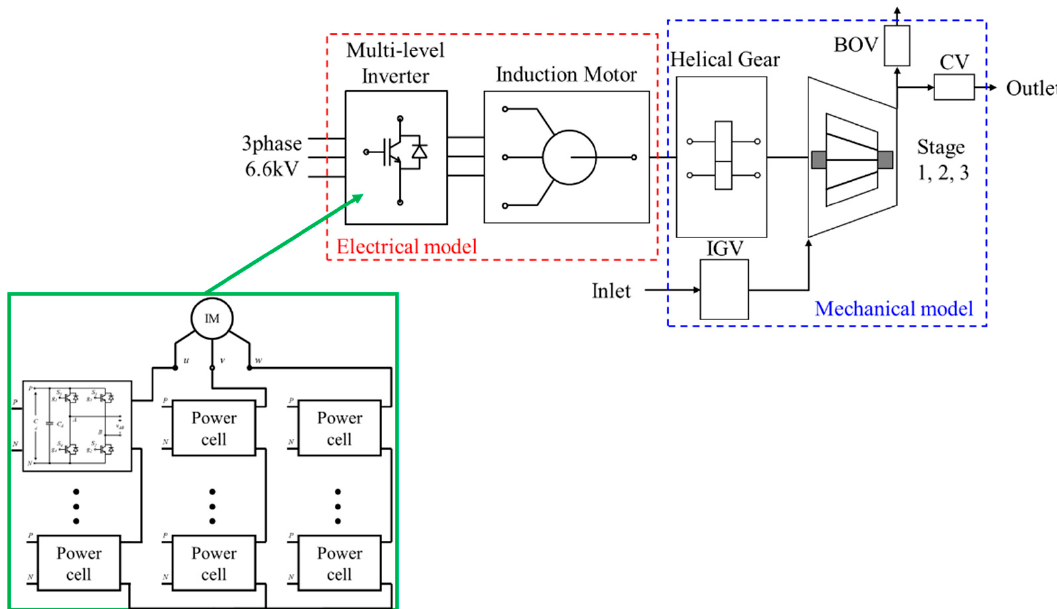
Figure 1. Configuration of turbo air compressor system